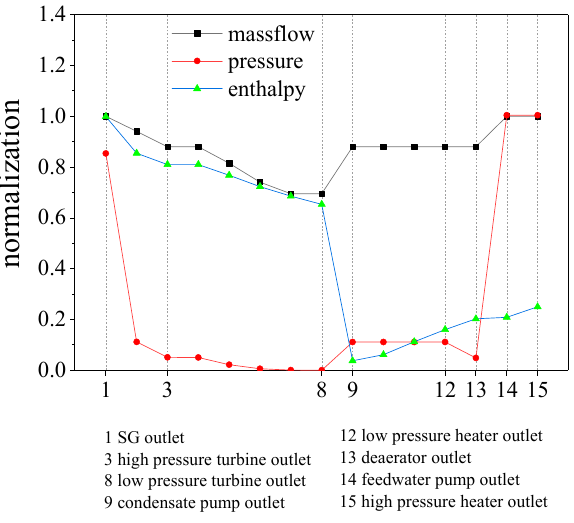
Figure 3. Numerical results of the secondary circuit.